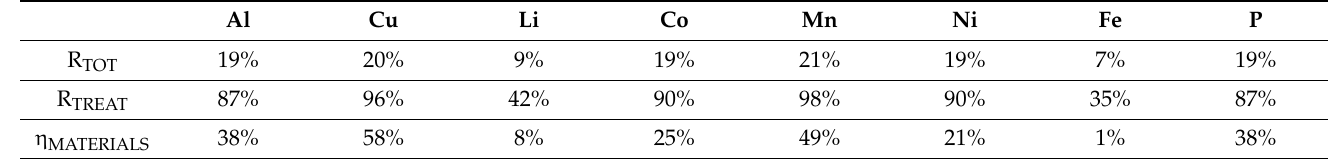
Table 4. Circularity indicators and recycling efficiency parameters (R TOT : amount of generated waste; R TREAT : number of treated wastes; η MATERIALS : efficiency of materials